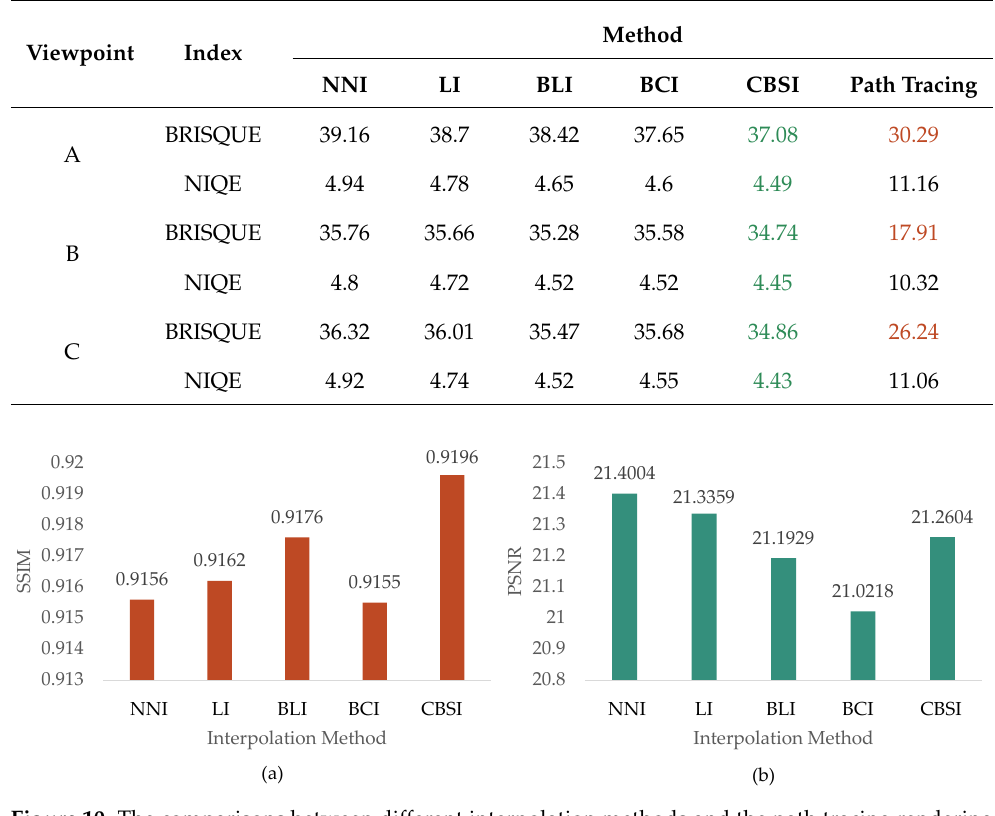
Table 2. The BRISQUE and NIQE evaluations on the novel views rendered by different methods. The green number indicates the best result among the different interpolation methods, and the red number indicates that path tracing method gets better results.